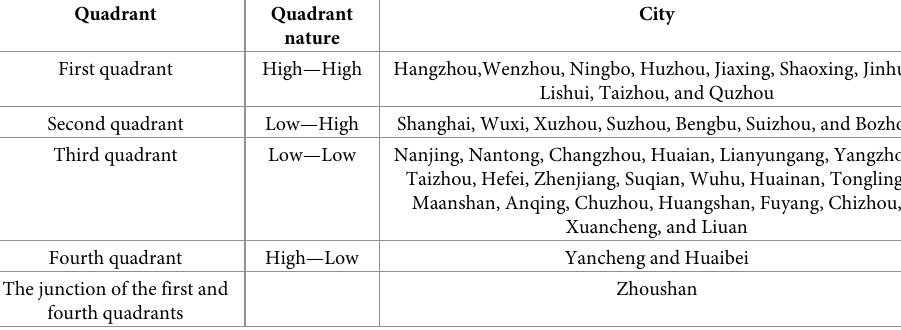
Table 5. Quadrant distribution of cities in the YRD region in